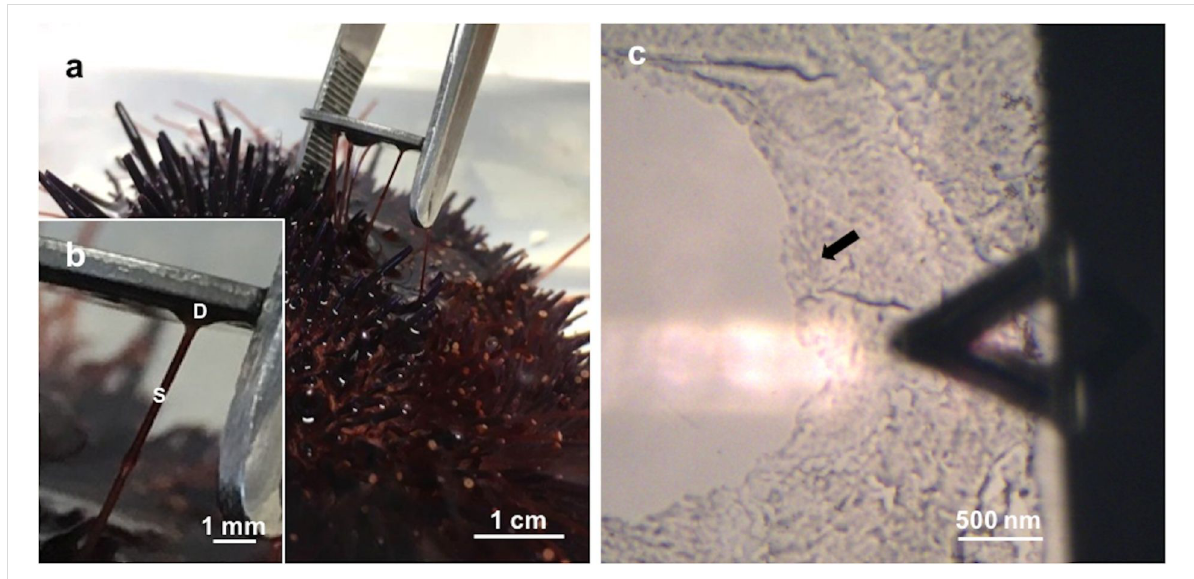
Figure 1: a) Collection of Paracentrotus lividus footprints on mica. b) Detailed view of a sea urchin tube foot attached to mica, showing the adhesive disc (D) and the stem (S). c) Optical microscopy (10×) illustrating the positioning of the moist adhesive footprint (indicated by the arrow) beneath the triangular-shaped AFM